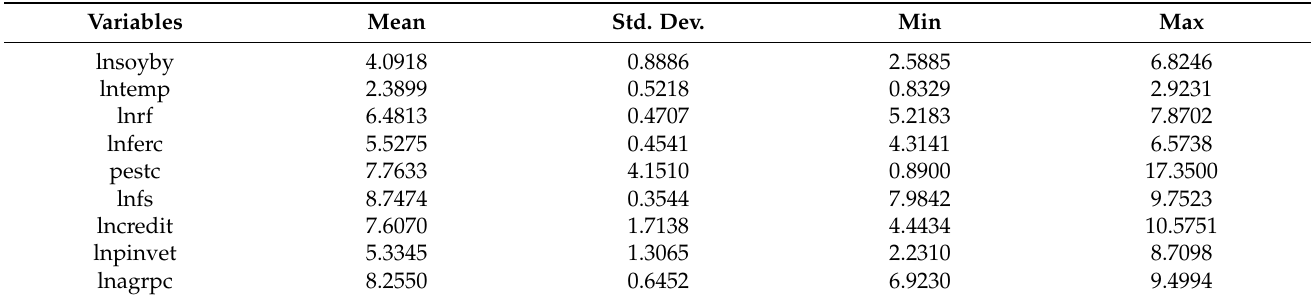
Table 2. The descriptive statistics of the studied